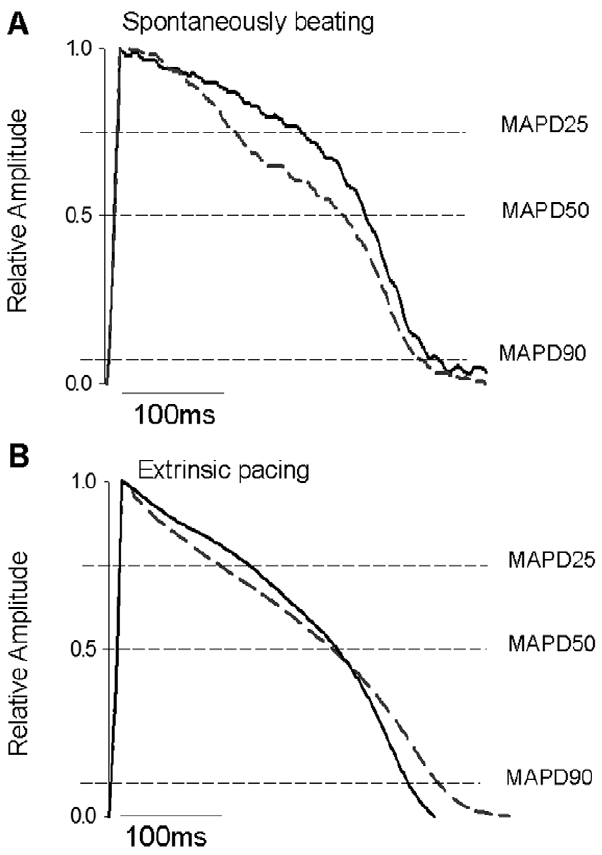
Figure 4. Representative MAP recordings from the working rainbow trout ventricle before and after stretch. The y-axis has been normalised to peak amplitude. (A) MAPs recorded from a spontaneously beating ventricle at a P i of 0.058 6 0.003 kPa, a P o of 0.5 kPa and a heart rate of 0.35 Hz (solid lines), and with a P i of 0.322 6 0.011 kPa, a P o of 7.5 kPa and a heart rate of 0.75 Hz (dashed lines). The shortening of MAPD25 can be observed. (B) MAP recordings taken from the surface of a ventricle extrinsically paced at 0.8 Hz. MAPs recorded at a P i of 0.322 6 0.011 kPa and a P o of 0.5 kPa (solid lines) and 7.5 kPa (dashed lines). A shortening of MAPD25 and an elongation of MAPD90 can be observed showing a classical stretch-induced cross over in the MAP waveform. Recordings shown are the average of 4 traces under each condition.